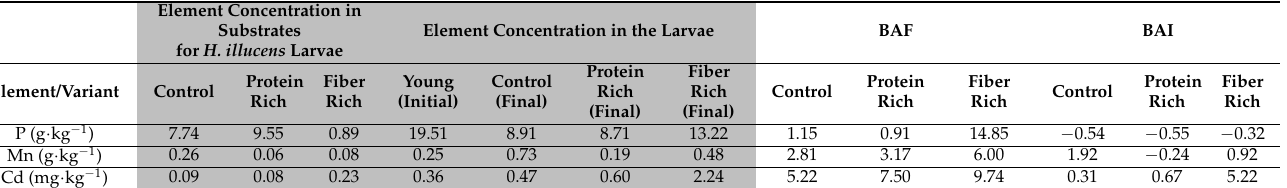
Table 1. The concentrations of selected elements in substrates used as feed for Hermetia illucens larvae and concentrations of these elements in the young larvae before (initial) and after (final) the experiment, according to publication [27] (gray cells). BAF and BAI values were calculated according to Equations (1) and (2), respectively. Element Concentration in Substrates Element Concentration in the Larvae BAF BAI for H. illucens Larvae Element/Variant Control Protein